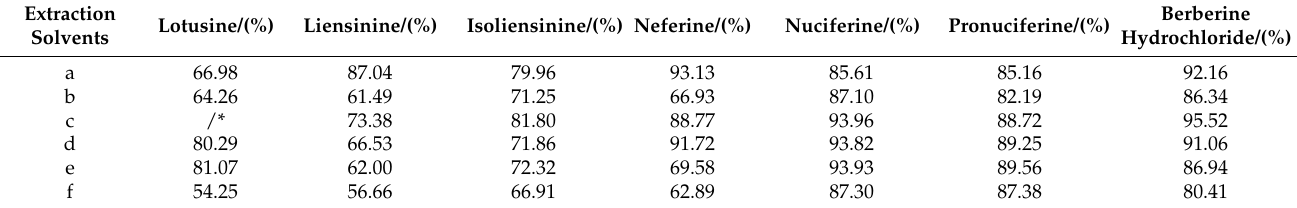
Table 3. Effects of different extraction solvents on extraction yields of seven kinds of